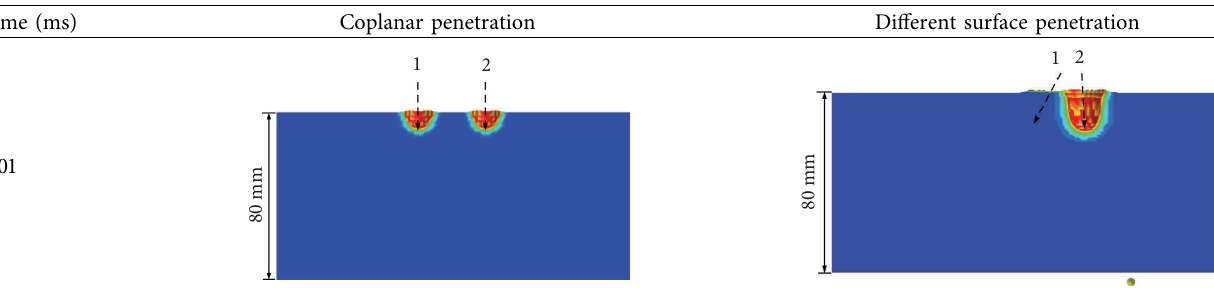
Table 13: Comparison of coplanar and heterogeneous joint